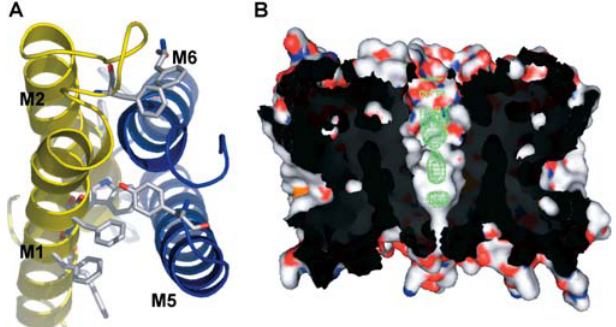
Figure 5. Oligomerization of AqpZ (A) Protomer–protomer interface. The interface is composed of helices M1 and M2 from one protomer (yellow) and M5 and M6 from a second protomer (blue). The helices participate in knobs into holes packing, and the interface is extensive (3,340 2 ) owing to the large number of aromatic residues. (B) Abstruse electron density along the 4-fold axis (colored in green). Two protomers are display in surface rendering. The experimental electron density (2F obs – F calc ) is contoured at 1.1 r . DOI: